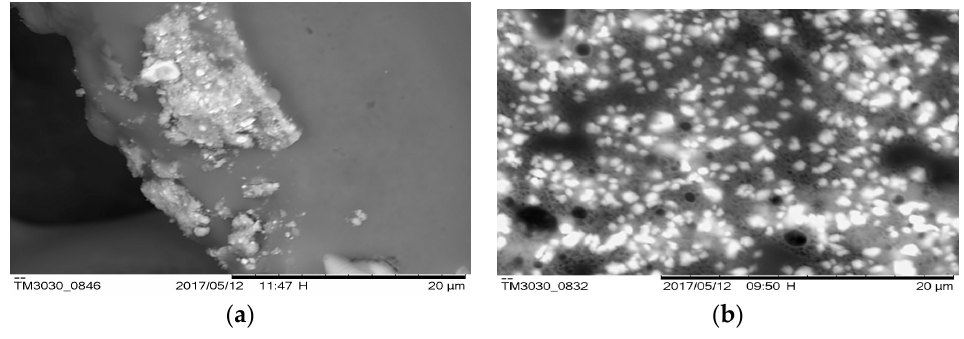
Figure 1. SEM images of ( a ) OAK-nZVI and ( b )